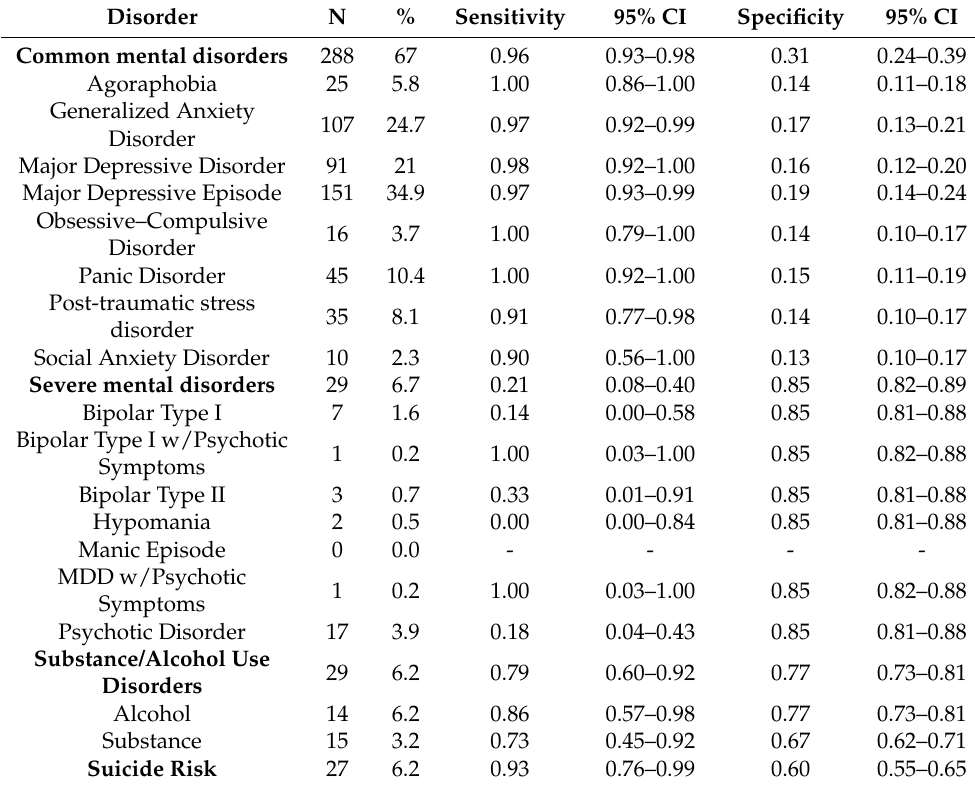
Table 3. Performance of 13-item E-mwTool in identification and classification of participants with mental disorders (n =